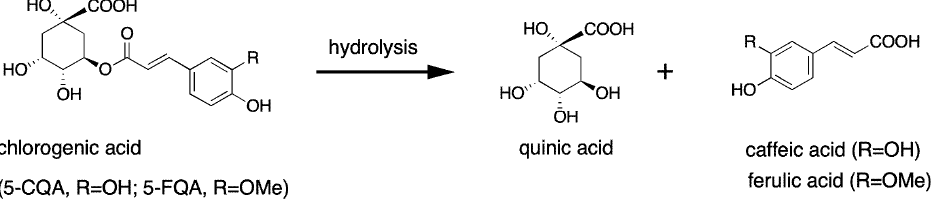
Figure 2. The metabolism of chlorogenic acids.